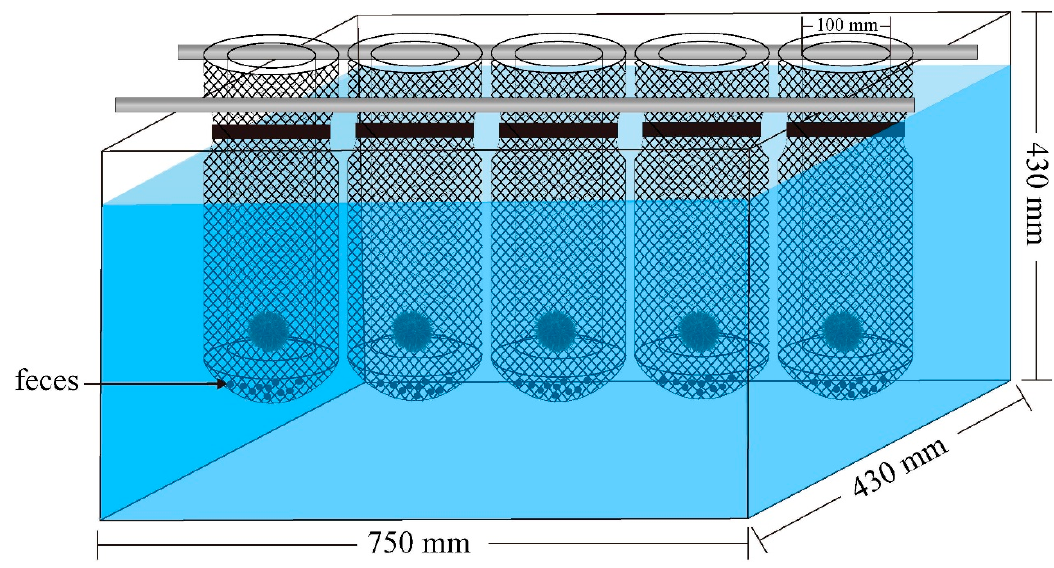
Figure 1. Diagram of the feces collection in each temperature-controlled tank.